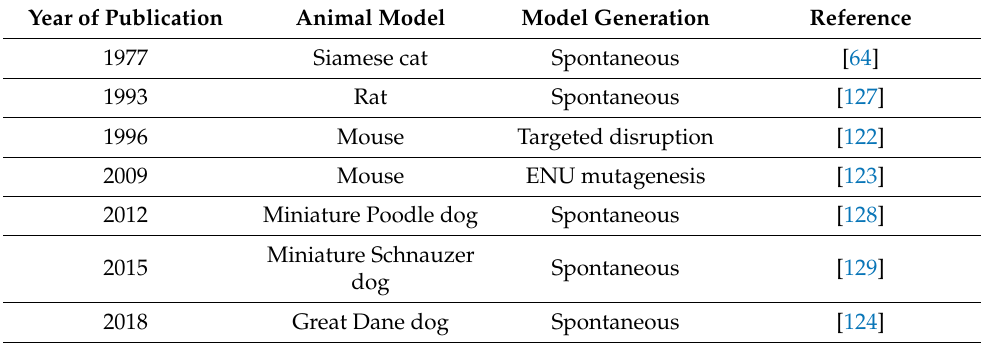
Table 2. Animal models for Mucopolysaccharidosis type VI. ENU =